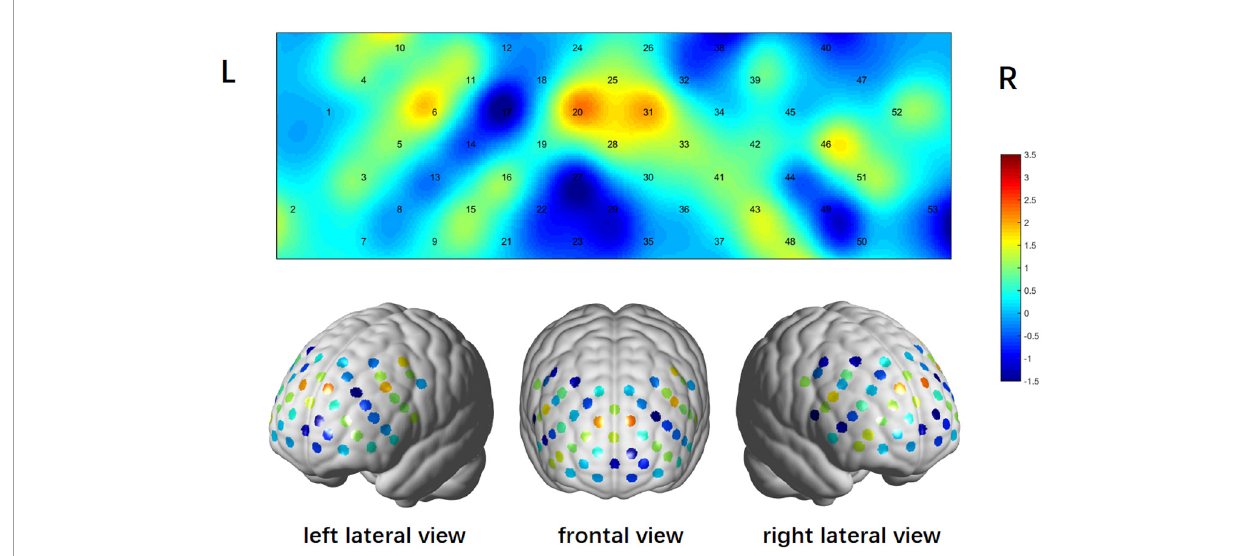
FIGURE3 Differences in task-related cortical activations between the PD-OAB and PD-NOAB groups.